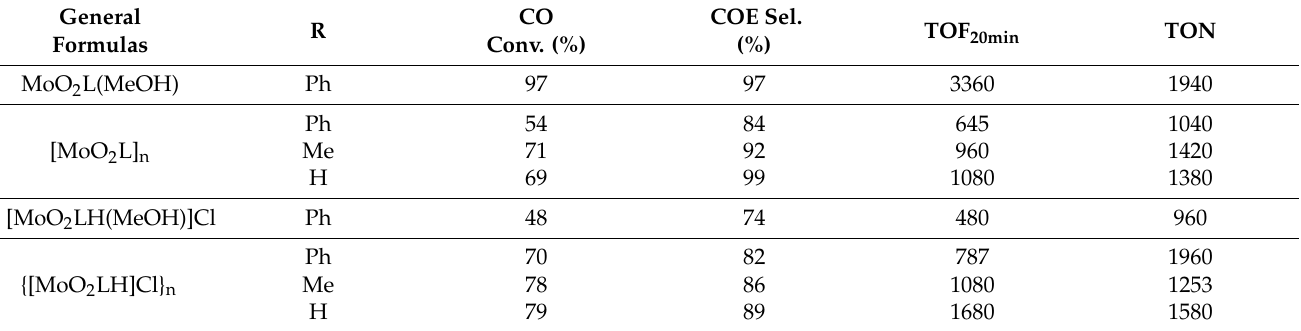
Figure 5. Monomeric and polymeric species studied containing the pyridoxal fragment in the thosemicarbazonato ligand. Species are neutral but can be also charged (pink part). Those species have been tested as catalysts and results (Table 2) indicated that the na- ture of R, catalytic ratio, charge (neutral/anionic) of the complex, and monomeric/polymeric form are all factors influencing the catalytic results. Table 2. Results of cyclo-octene (CO) epoxidation and selectivity towards cyclo-octene oxide (COE) under organic solvent free conditions catalyzed with MoO 2 L complexes from Figure 5.